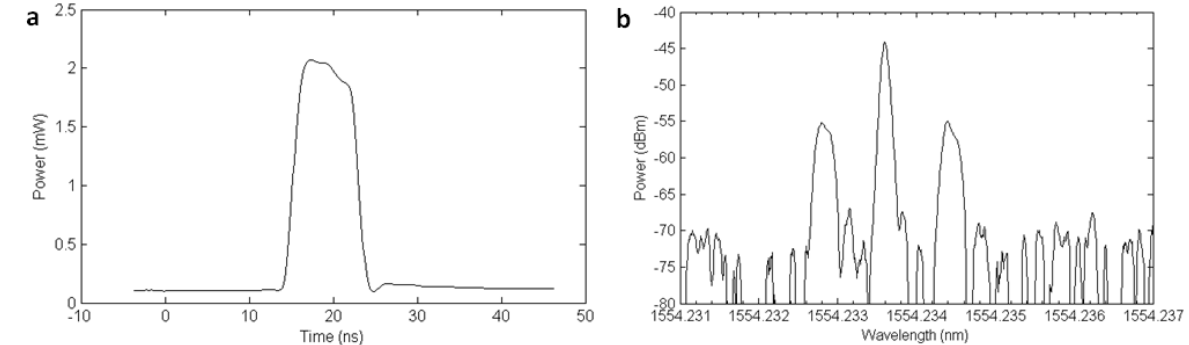
Figure 7. ( a ) Optical pulses generated in the system; ( b ) Optical spectrum at the exit of the